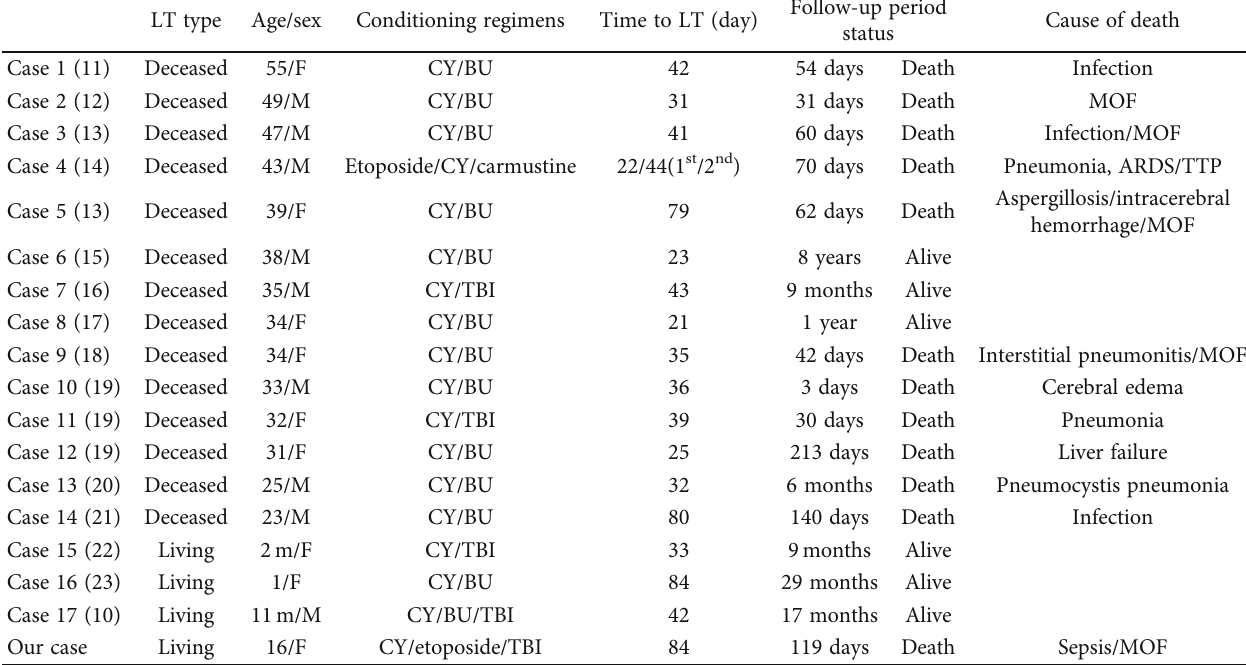
Table 1: Data of previous reports on liver transplantation for VOD/SOS originating from